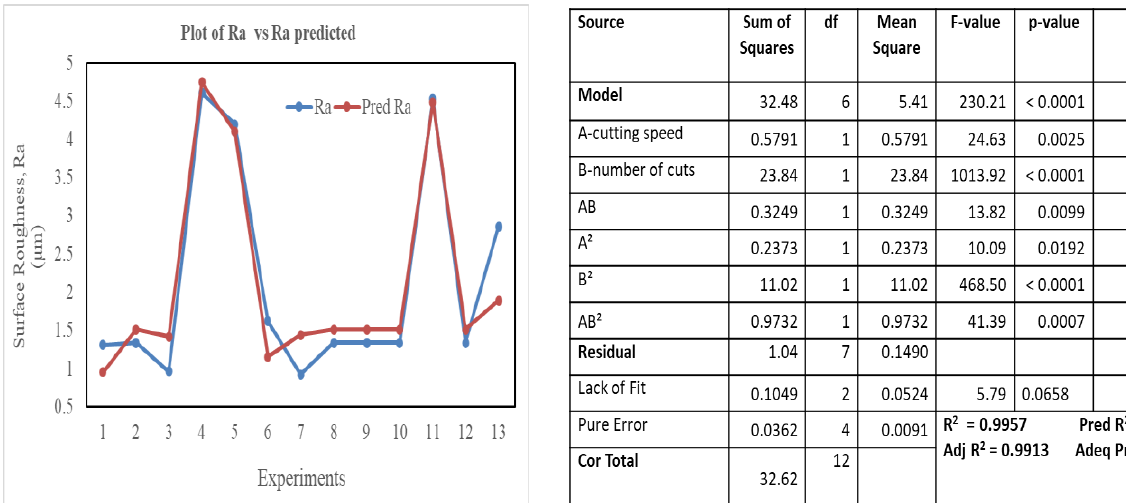
Figure 15. Plot of Ra vs predicted Ra, ANOVA model for Ti-6Al-4V.